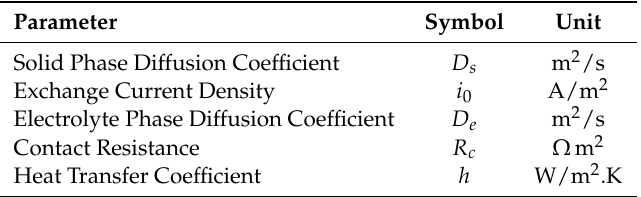
Table 2. Factors affecting cell voltage and temperature under